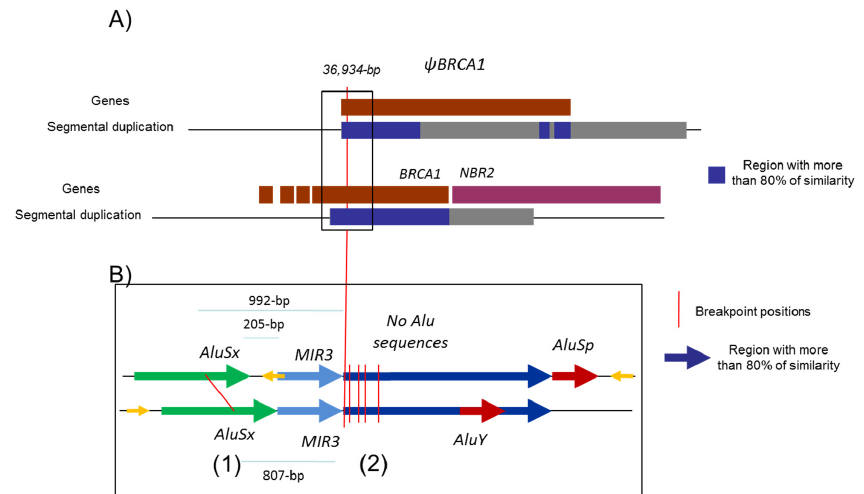
Figure 5. Structural organization of BRCA1 5 ′ region. ( A ) Proposed structural interaction to explain the non-allelic homologous recombination which leads to the 36,934 bp deletion reported here (in F1 and F5 families) and in the literature (Lit1, Lit2). BRCA1 and pseudoBRCA1 are represented in brown and NBR2 in purple. Under the genes, blue and grey boxes represent segmental duplications, with the blue box presenting more than 80% similarity. There is likely a chromatin loop which facilitates the recombination by bringing the two loci close together. ( B ) Analysis of the similarity of Ψ BRCA1 and BRCA1 gene in the region with the reported breakpoints—chr17:43155400–43157973 and chr17:43118270–43121226. ( 1 ) Breakpoints identified in F2, F3, F4 and their distance to the segmental duplication with high homology (blue array); ( 2 ) breakpoints of F1, F5, Lit1 and